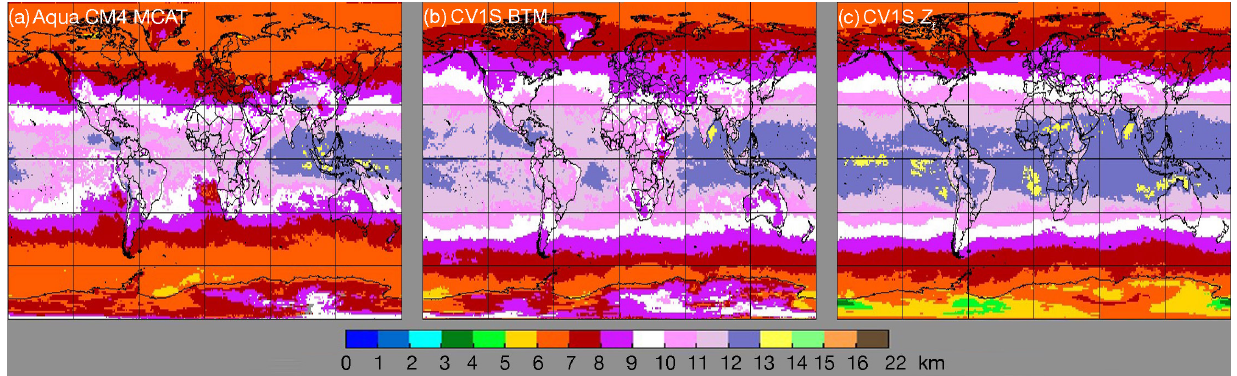
Figure 14. Mean 2013 cloud-top heights from ( a ) Aqua CM4 MCAT, ( b ) CV1S BTM, and ( c ) CV1S standard retrieval for ice clouds.